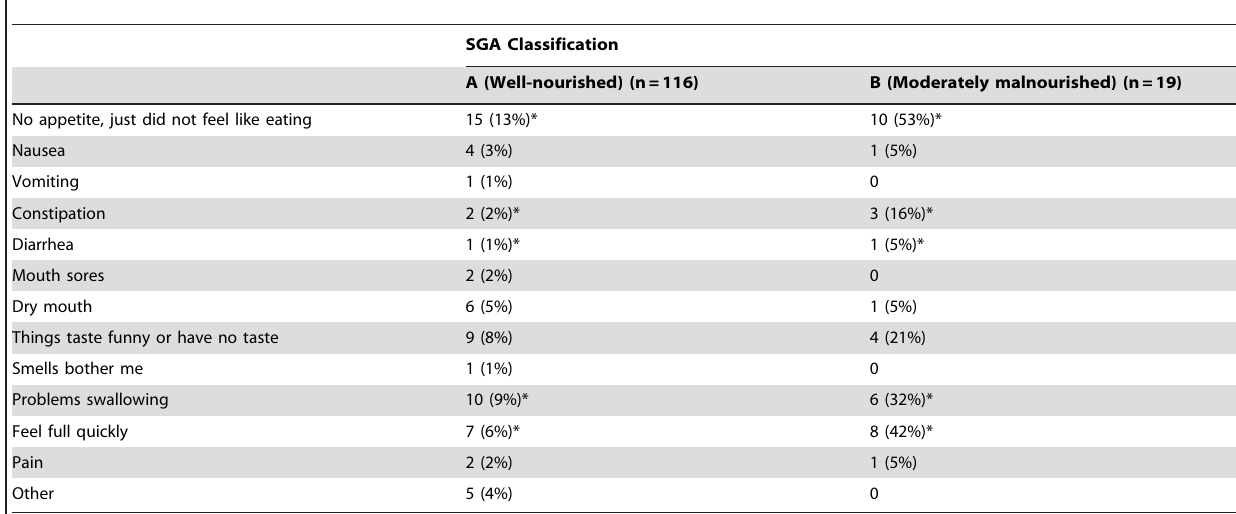
Table 2. Nutrition impact symptoms as reported on the PG-SGA compared between SGA groups using Chi-square analysis.